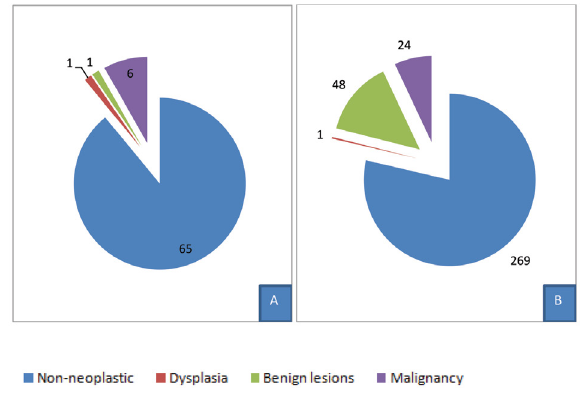
Figure 3: Distribution of the diagnostic category